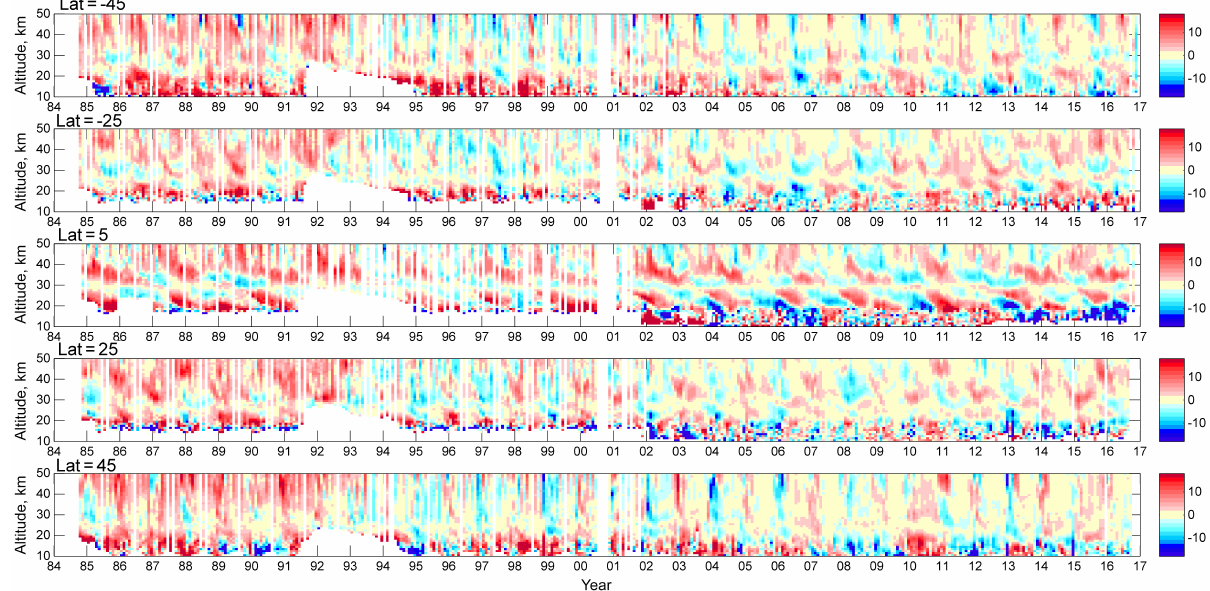
Figure 8. Examples of merged deseasonalized anomalies (color: %), for several 10 ◦ latitude bands, centers of which are specified in the legend.